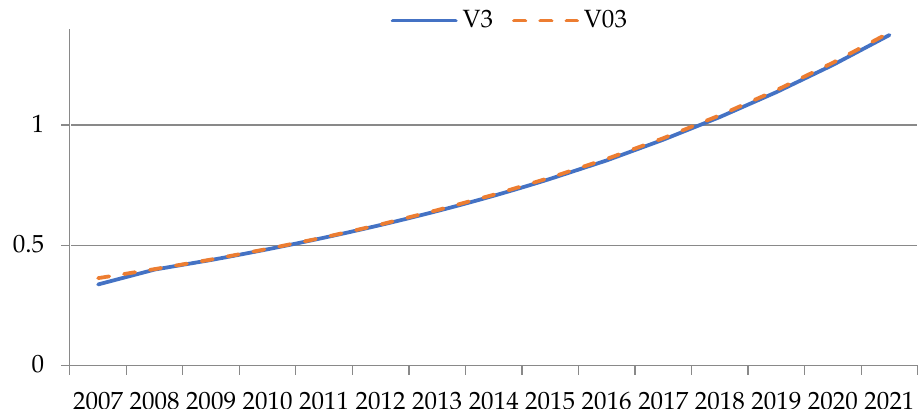
Figure 9. Graphs for tracking the target revenue indicator for industry No. 3 (author’s results).